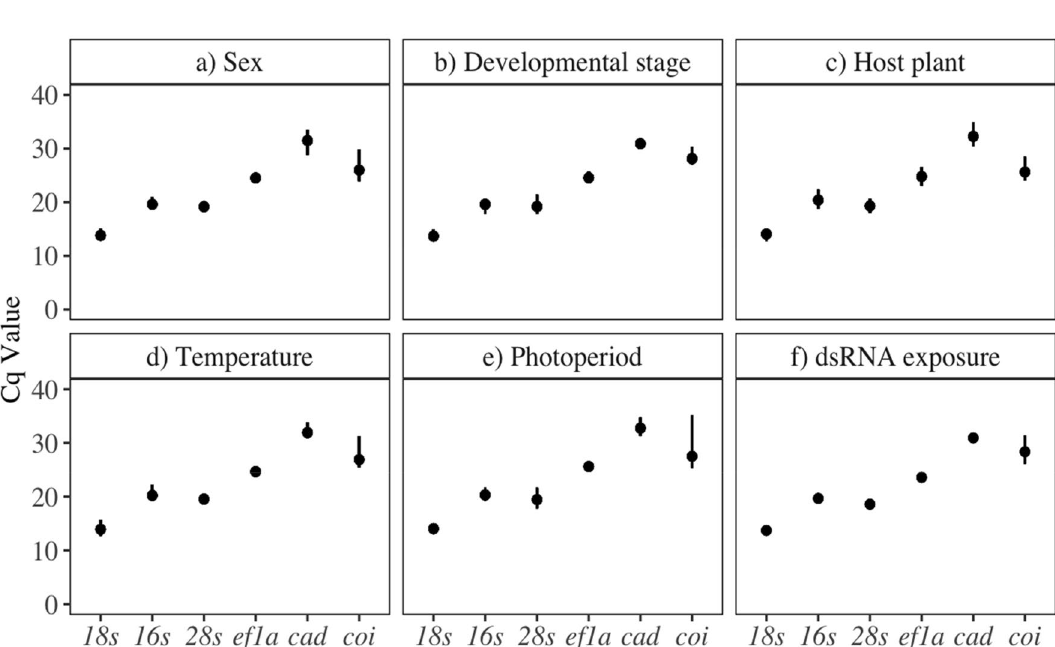
Figure 3. Average Cq values for each candidate reference gene by: ( a ) beetle sex, ( b ) developmental stage, ( c ) host plant, ( d ) temperature, ( e ) photoperiod, and ( f ) dsRNA exposure. Error bars represent the maximum and minimum Cq values, n = 5 beetles per